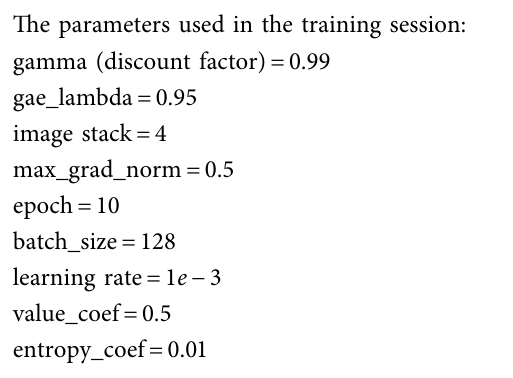
Figure 5: Modifed display of parameters in real time. Showing reward/ABS sensor/speed/wheel angle/angular velocity